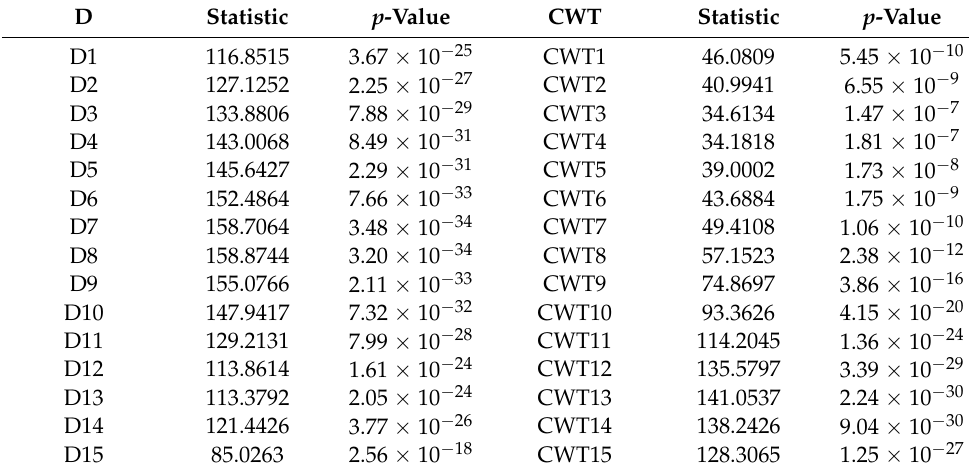
Table 2. Kruskal–Wallis rank statistics and corresponding p -values applied to 30-dimensional tra- cheidograms (vectors) (D1, D2, D3, . . . , D15; CWT1, CWT2, CWT3, . . . , CWT15), allocated into four classes. D Statistic p -Value CWT Statistic p -Value